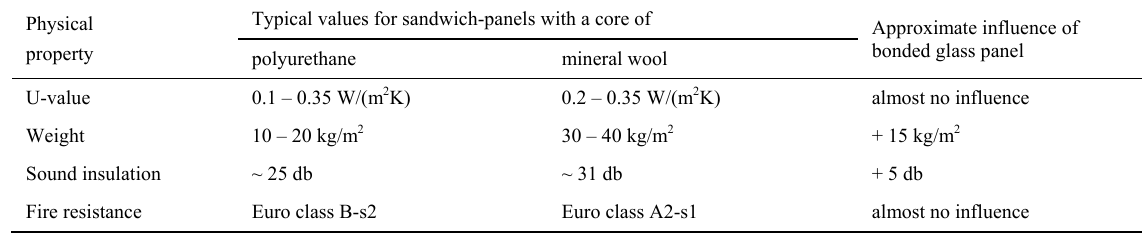
Table 1: Properties of sandwich panels and influence of 6 mm thick glass